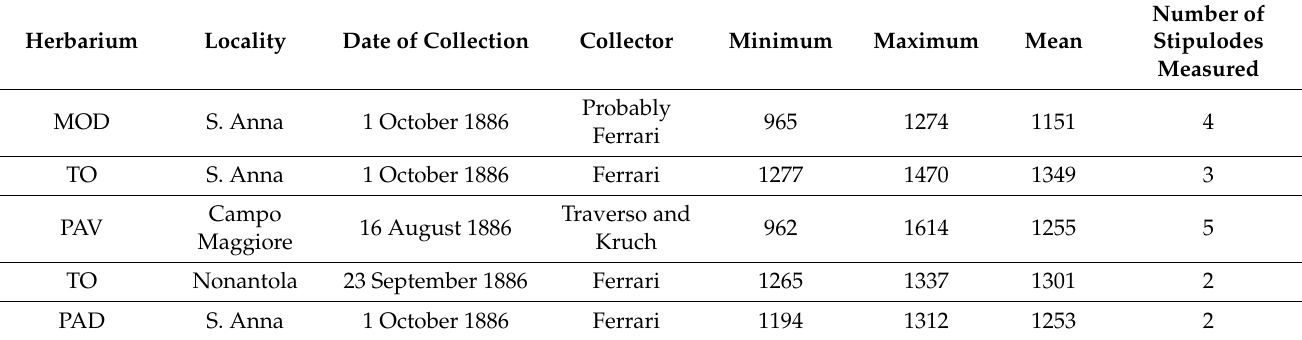
Table 4. Lengths of stipulodes. All values are presented in µ